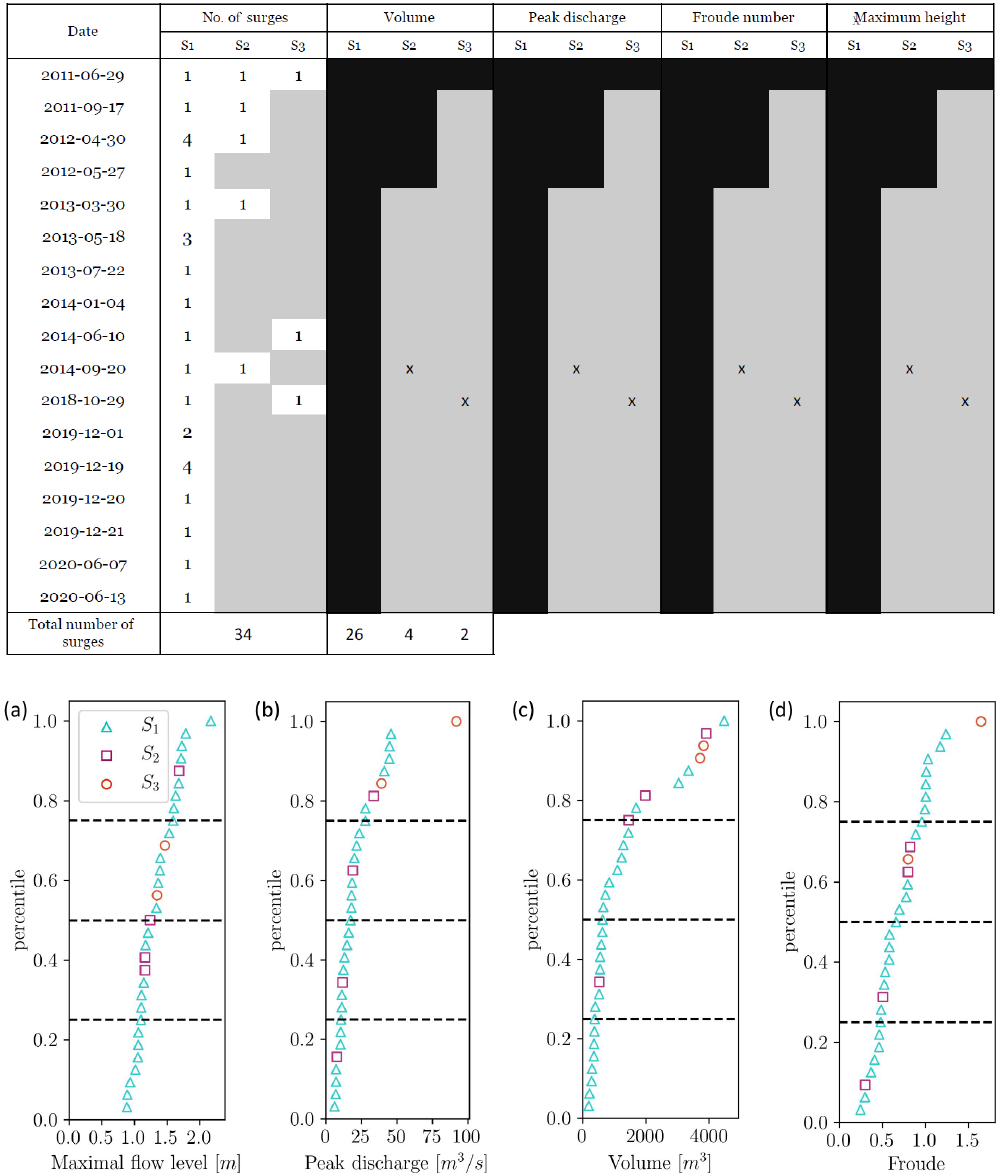
Table 2. Summary of the available data. Black cells correspond to available data. Grey cells are non-applicable. Crossed-out cells are events that were detected but for which the data were not retrieved due to faulty sensors. Please note that the date format in this table is year-month- day.